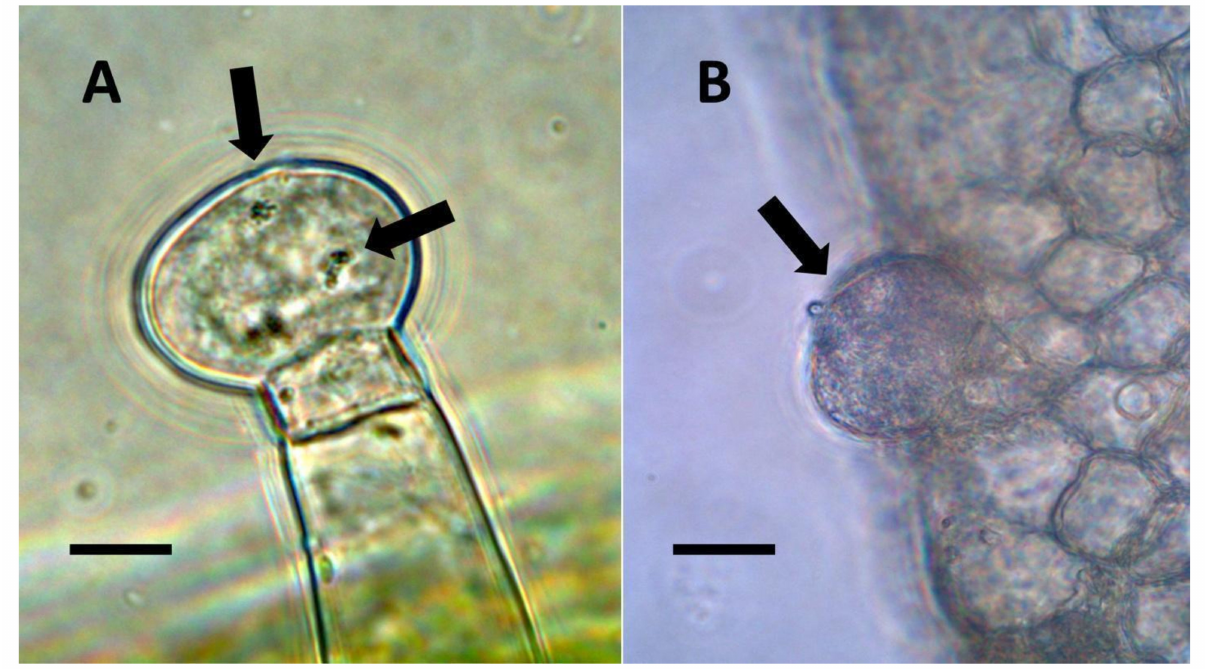
Figure 7. Glandular trichomes of Verbascum thapsus and Humulus lupulus . ( A ) Verbascum thapsus leaf glandular trichome stained with acidified diphenylamine to show nitrate (blue-purple color) around bacteria (arrows) in trichomes (Bar = 10 µ m). ( B ) Humulus lupulus inflorescence bract glan- dular trichome (arrow) stained with acidified diphenylamine to show nitrate (blue-purple color) accumulation in trichome (Bar = 10 µ m).